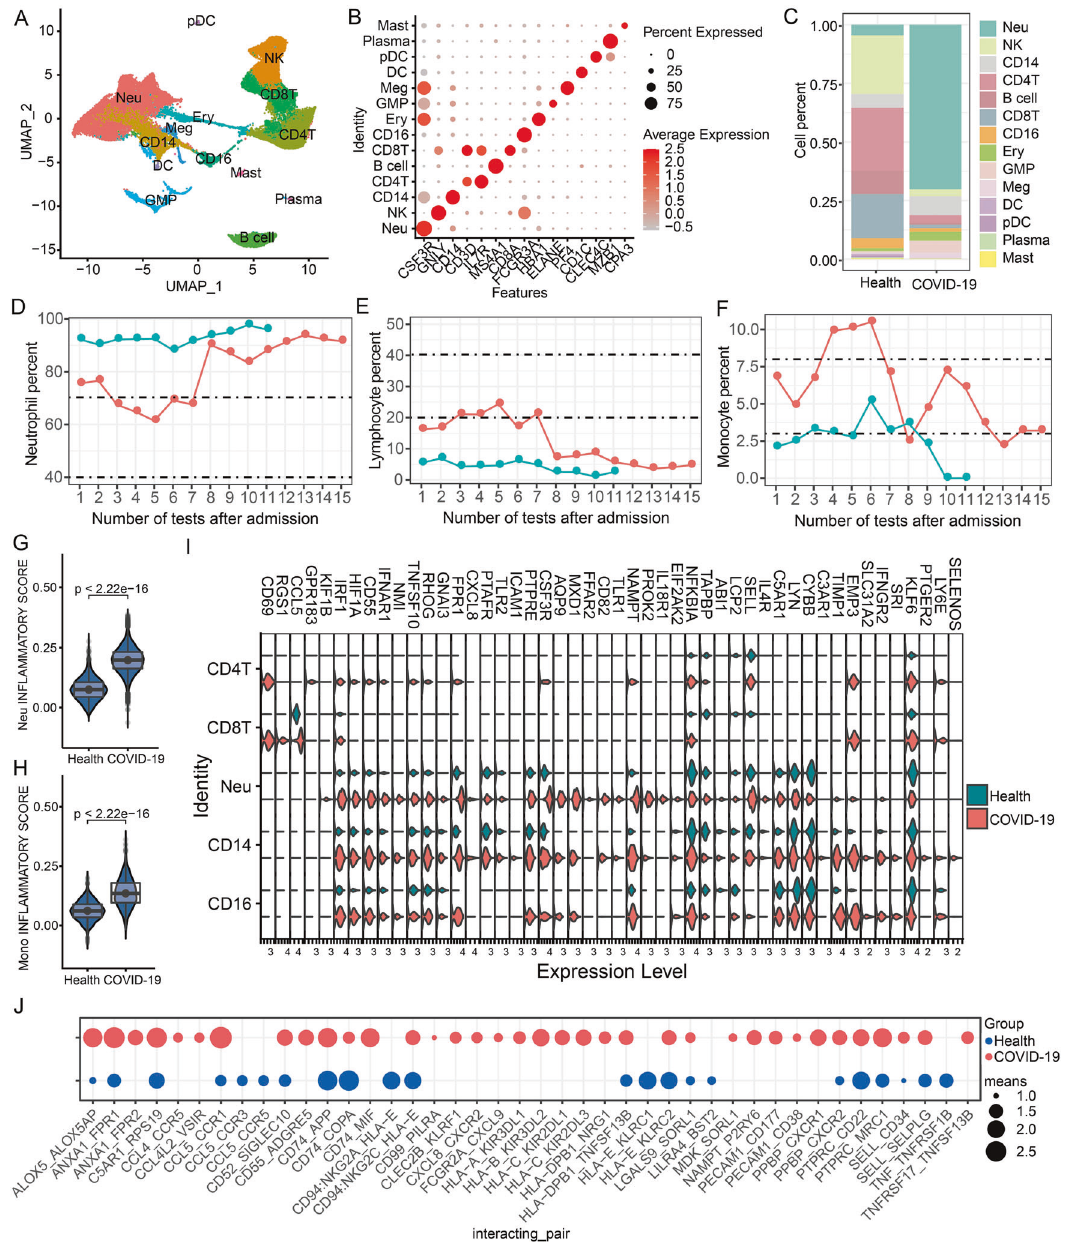
proportion of different cell types in the blood of healthy groups and COVID-19 patients. D , F Detect the ratio of neutrophils, lymphocytes, and monocytes in the blood of two COVID-19 patients. Blood was collected multiple times for testing before death. The dashed lines represent the normal reference range. G , H Differences in in fl ammatory gene set scores between neutrophils and monocytes in healthy groups and COVID- 19 patients. I Signi fi cantly differentially expressed in fl ammation-related genes in blood neutrophils and monocytes in healthy groups and COVID-19 patients. J Signi fi cantly changed ligand and receptor molecules in the blood of healthy group and COVID-19 patients. The “ means ” in the legend represent the activity of the cell communication molecule